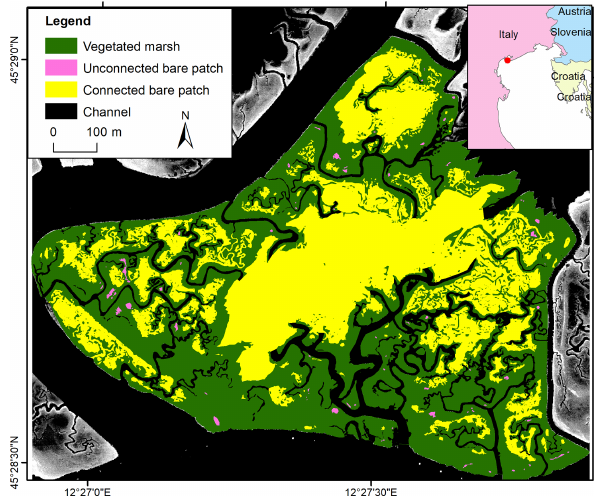
Figure 2. Study area in the San Felice marsh. Spatial distribution of vegetated marshes, unconnected bare patches, and connected bare patches in 2002 with lidar images as